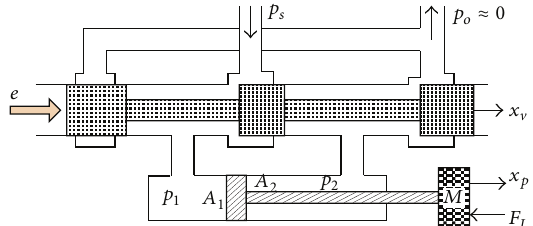
Figure 2: Structure of the valve-controlled asymmetrical hydraulic